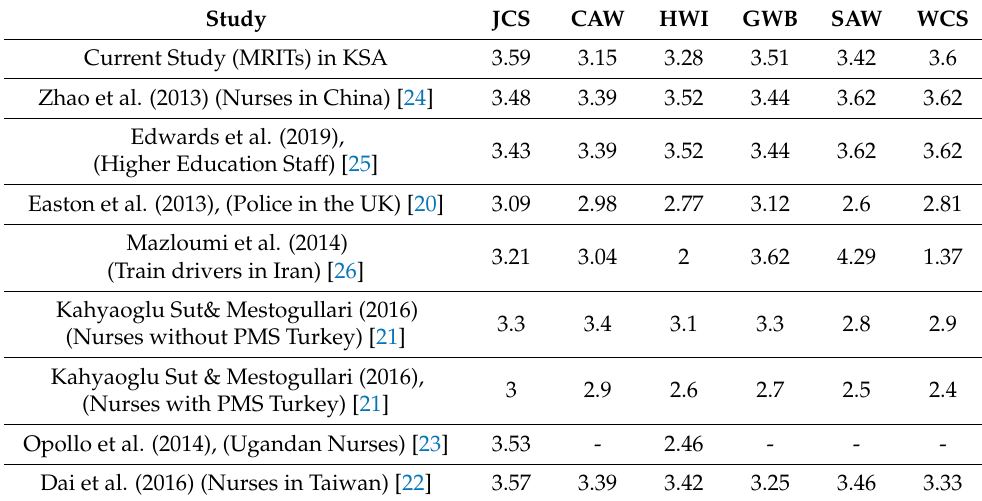
Table 8. Comparison of WRQoL-2 Scale Across Multiple Studies. Study JCS CAW